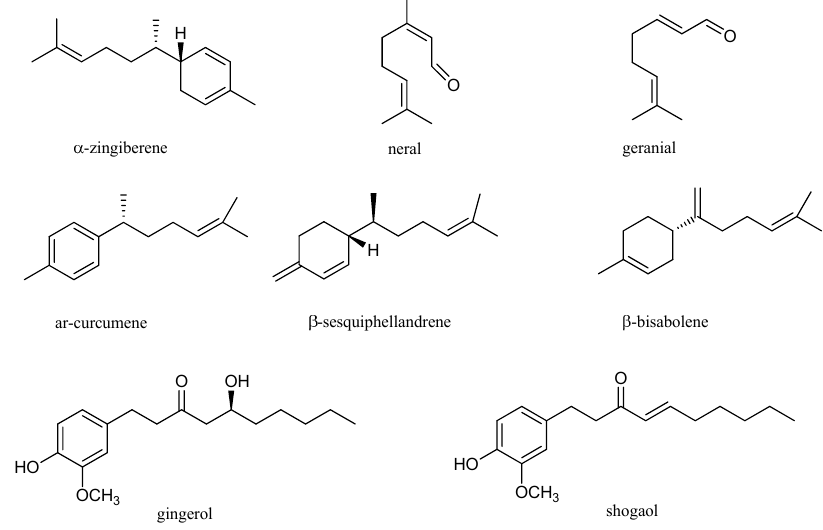
Figure 1. Chemical structures of major components of Z. officinale.